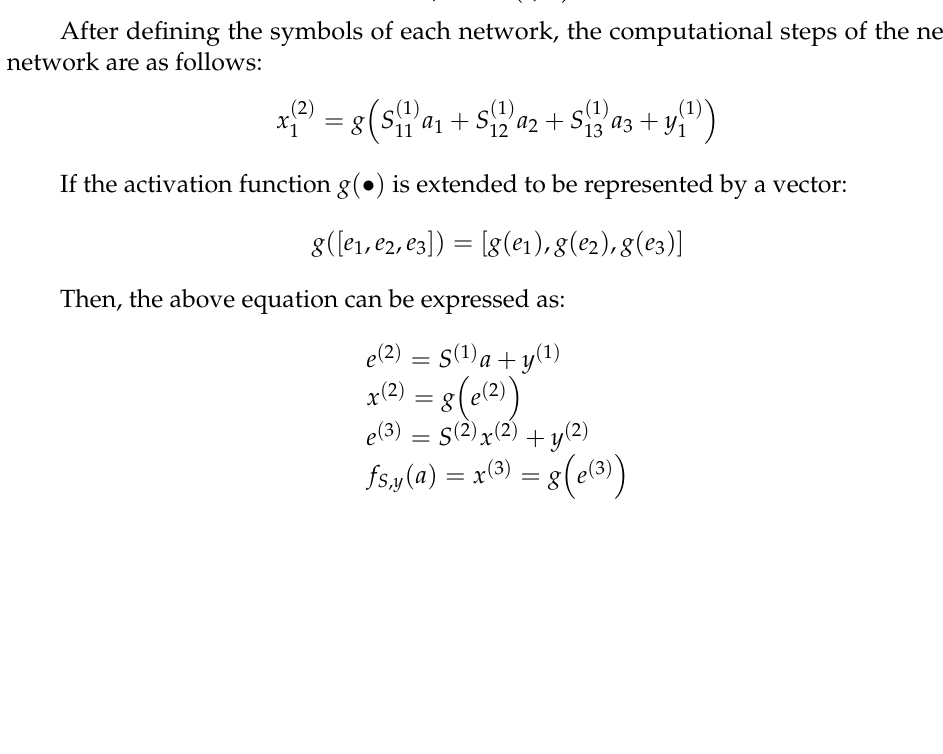
Figure 5. Neural network model.